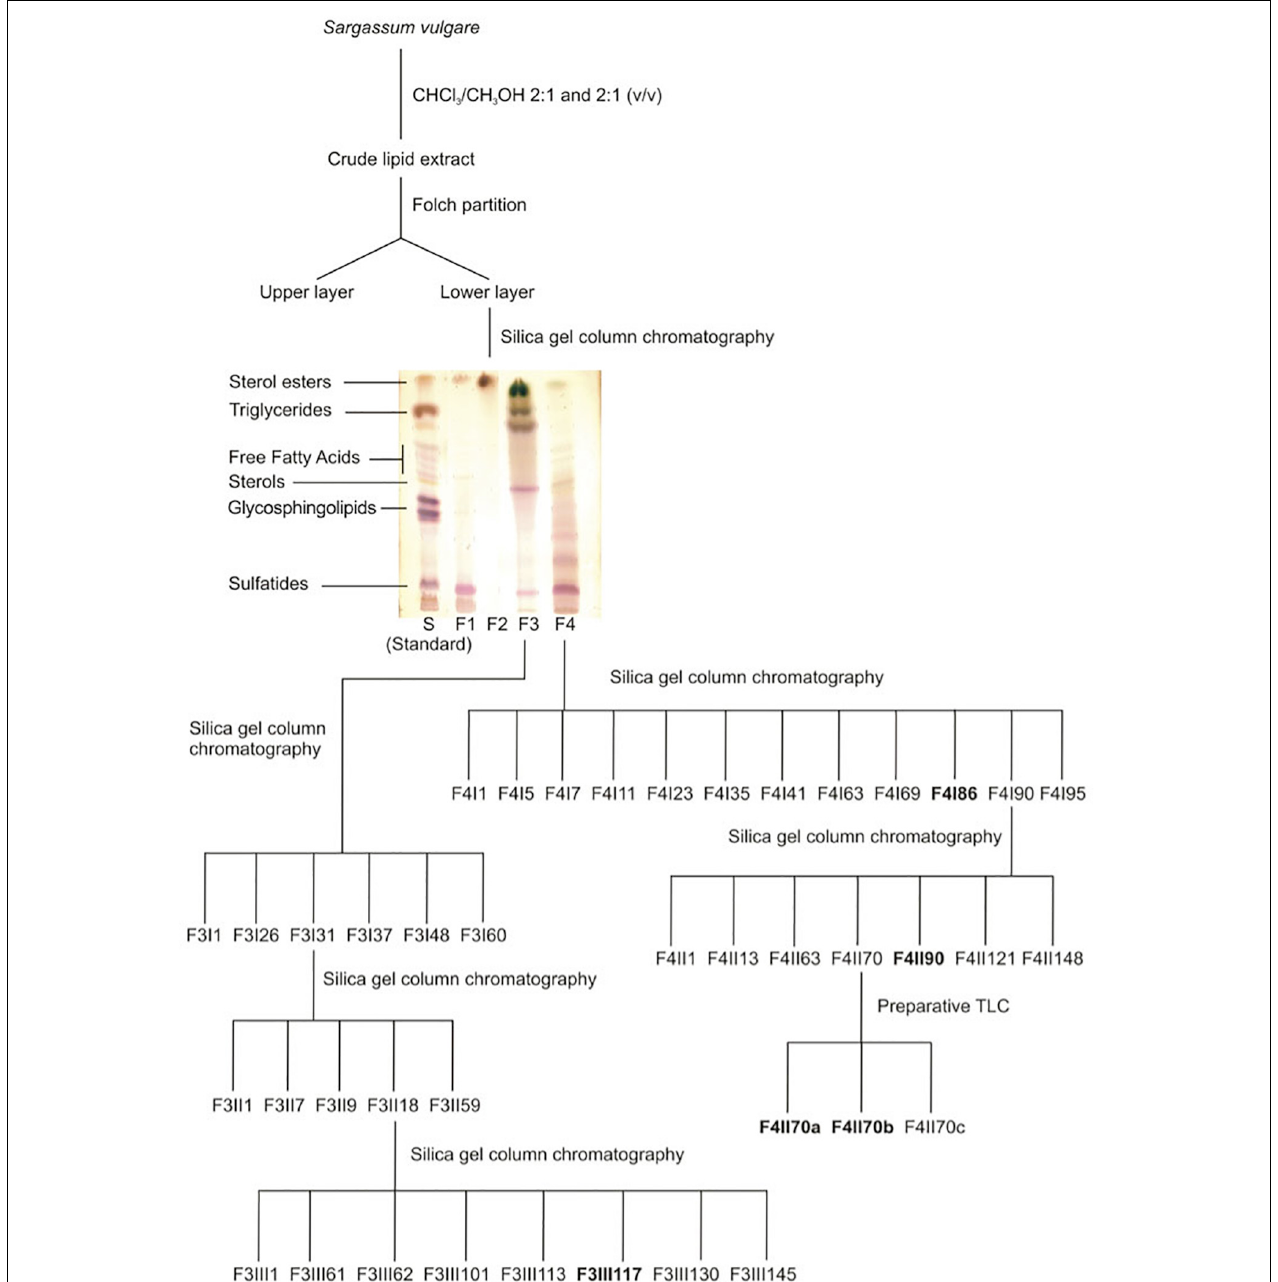
FIGURE 1 | Resumed purification protocol of glycolipids from S. vulgare